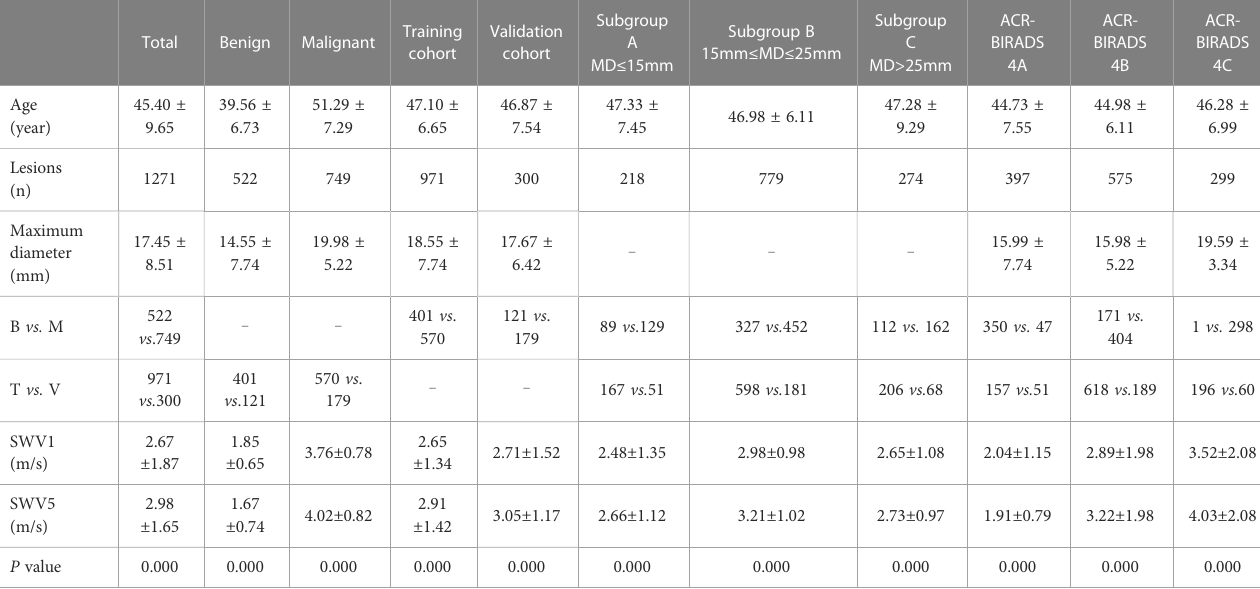
The Dice coef fi cient and Cohen ’ s kappa had the best values in Radiologist 2-CNN (0.83; 0.82); the speci fi city had the best values in Radiologist 3-CNN (0.99); and the 95% Symmetric Hausdorff Distance had the best values in Radiologist 1-CNN (1.19 mm) (Table 3). The box-plot diagrams show the intra- and interrater consistency of the radiologists and the CNN model compared to the radiologists (Figure 6). The Pearson ’ s correlation coef fi cients showed a strong relationship between the area, major and minor axis length between all of the observers (radiologists vs. CNN model r = 0.98, 0.97, 0.99). As shown in Bland – Altman plots, the differences between the CNN model and the three radiologists in segmentation area, major axis length, and minor axis length were almost 0 (Figure 7).